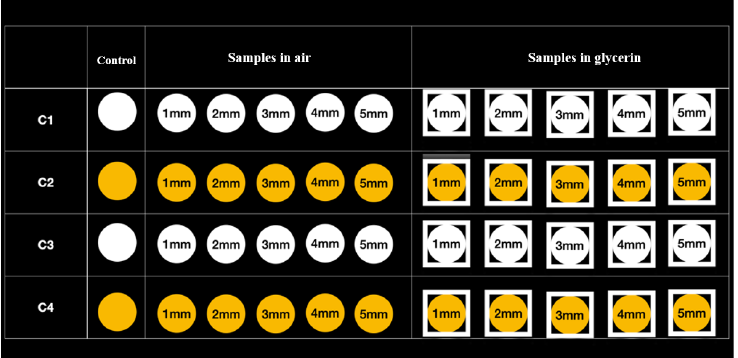
Figure 2. Preparation of C1÷4 dental restorative materials in different crosslinking environments at various distances from the light curing source. various distances from the light curing